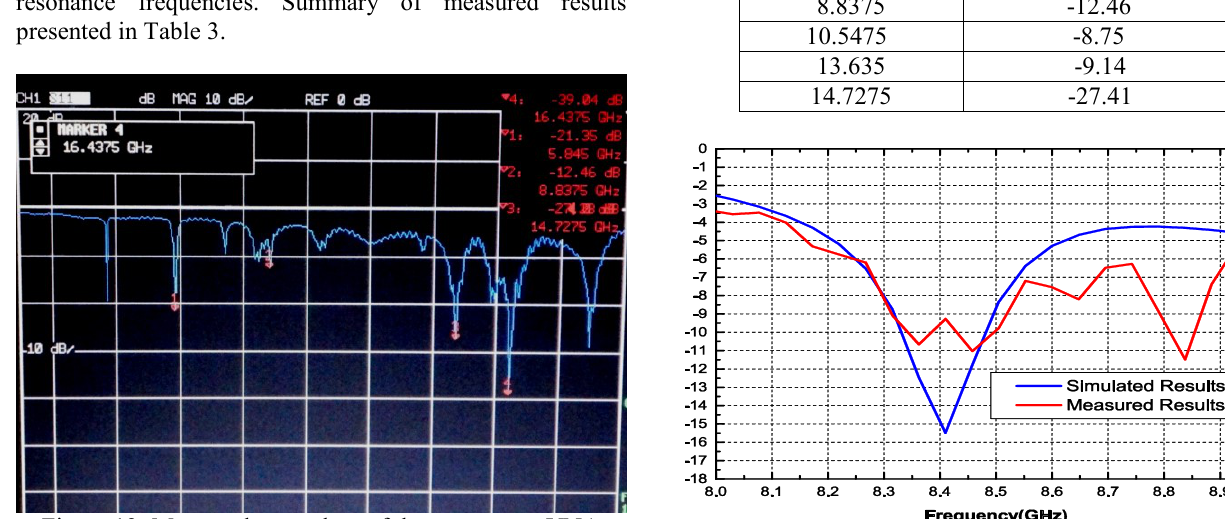
Figure 12: Measured return loss of the antenna on VNA